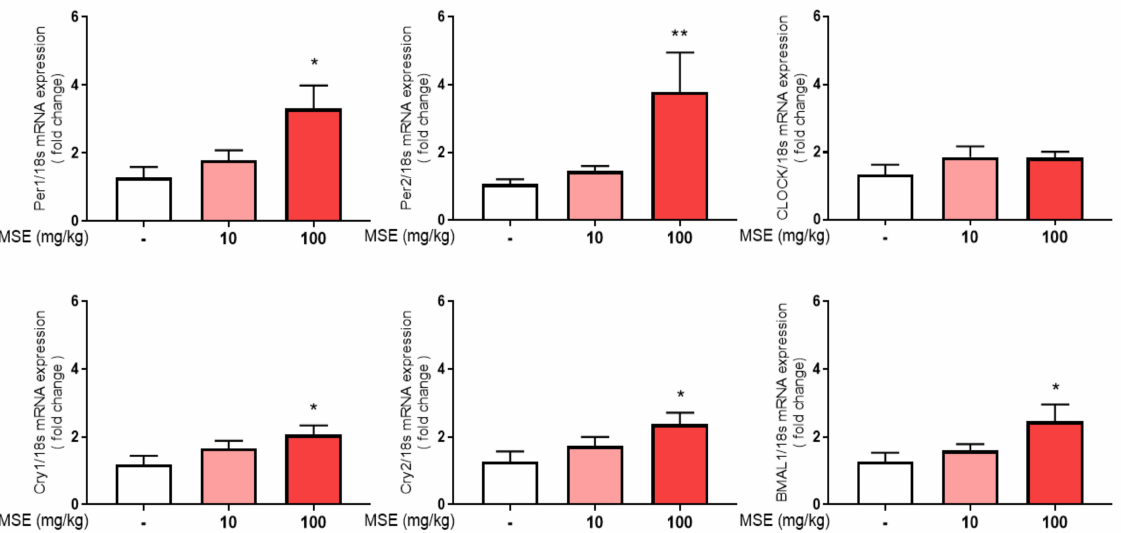
Figure 5. Effects of Maydis stigma extracts on the expression of clock genes in the brain. Mice were administered MSE (10, 100 mg/kg) for 7 days. After sleeping test, the mice were sacrificed, and the brain was dissected. qRT-PCR was performed to measure the expression of clock genes including Per1 and 2 , Cry1 and 2 , Clock , and Bmal1 in the hypothalamus. * p < 0.05, ** p < 0.01; Veh vs. MSE (N =